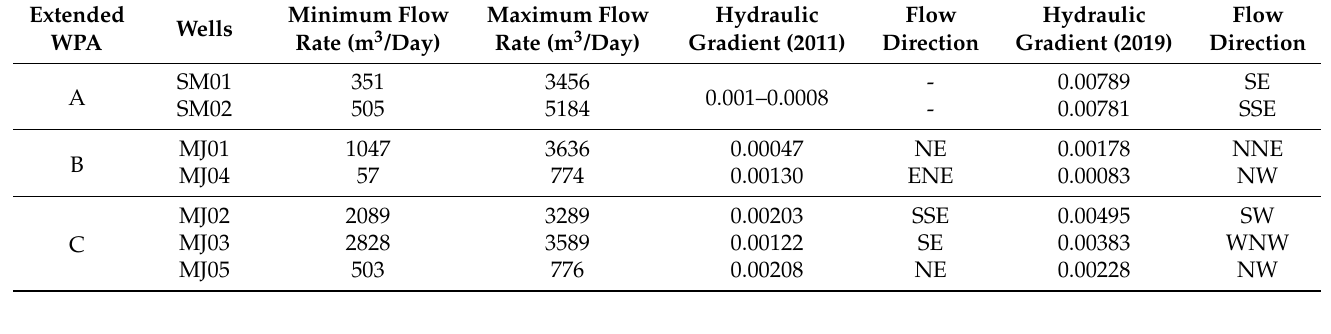
Table 3. Minimum and maximum flowrates for the wells and comparison between the hydraulic gradients and groundwater flow direction, used for delimitation of the actual WPAs (2011), and data from 2019.